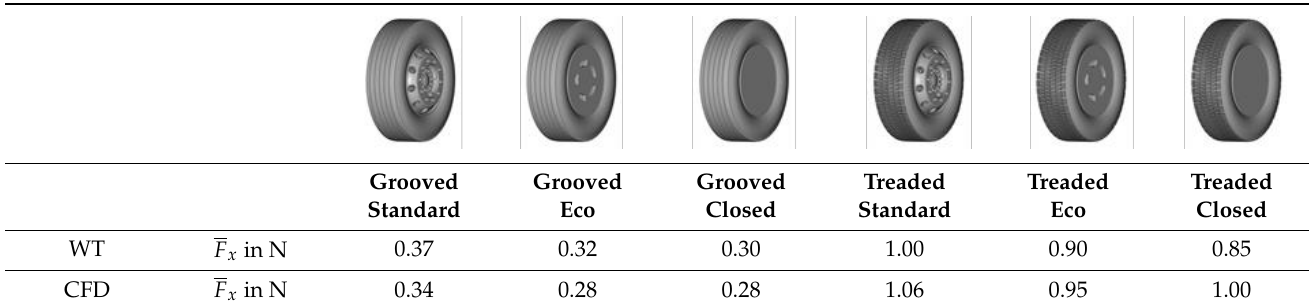
wheel configurations.